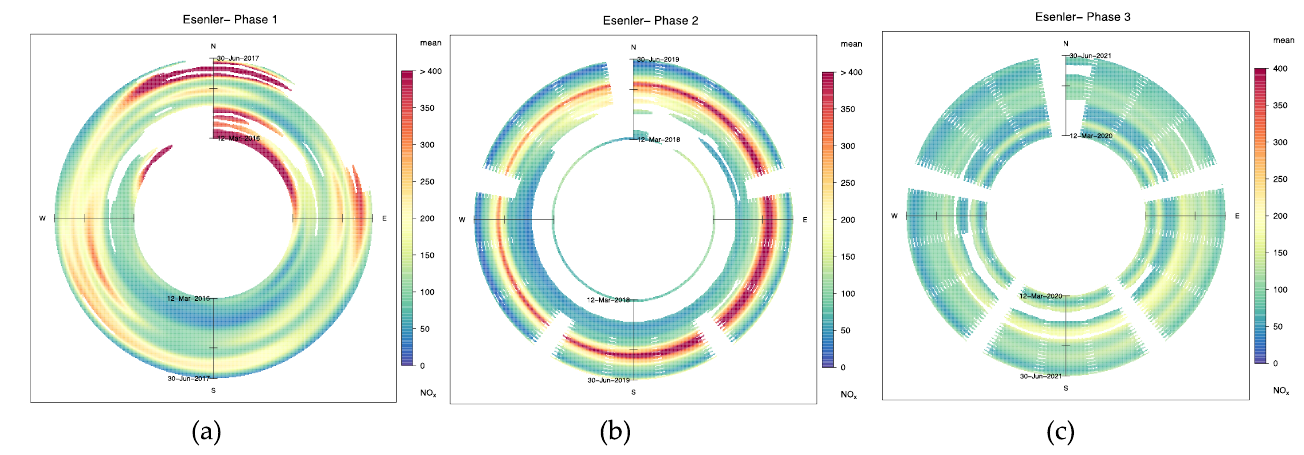
Figure A1. Directional trends of NO x ( μ g/m 3 ) for Esenler station: ( a ) Esenler Station NO x ( μ g/m 3 ) trends for Phase I; ( b ) Esenler Station NO x ( μ g/m 3 ) trends for Phase II; ( c ) Esenler Station NO x ( μ g/m 3 ) trends for Phase III.